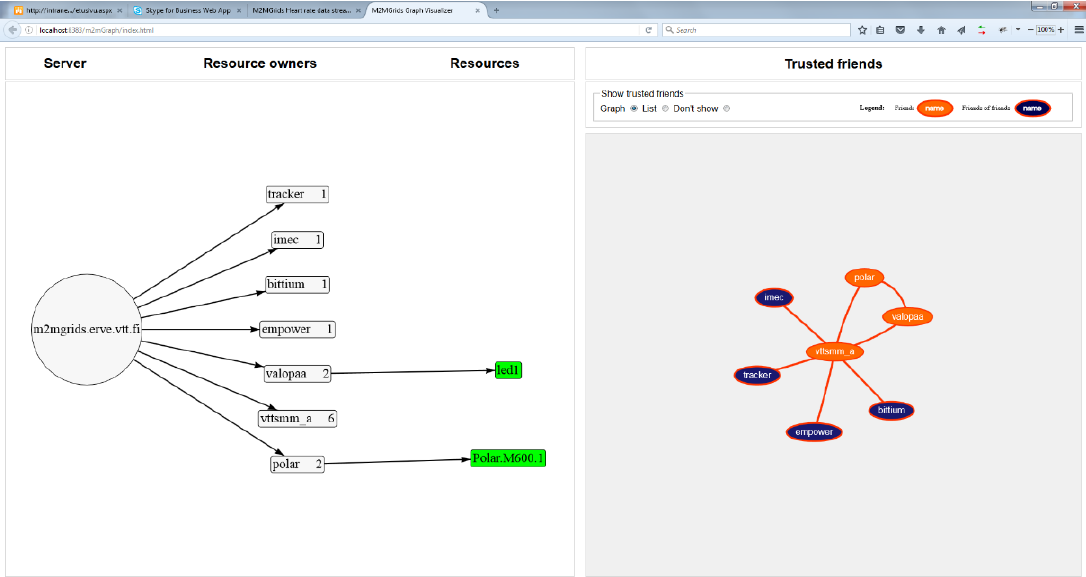
Figure 20. Visualization of the presence and trust relationship in the CPS hub.